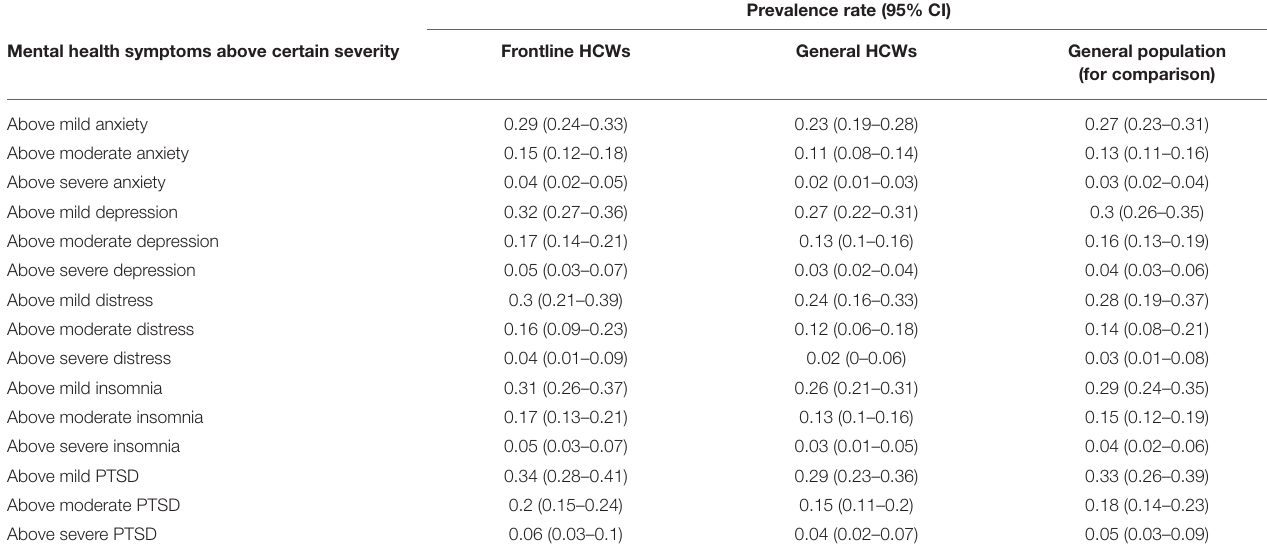
Prevalence rate (95% CI)